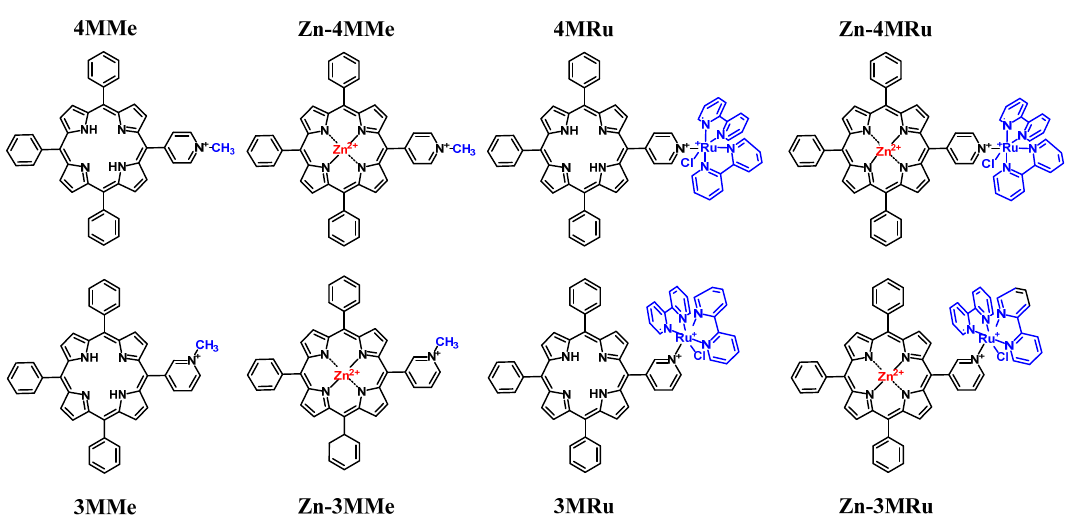
Figure 17. Molecular structures of some hydrophobic porphyrins and metalloporphyrins encapsulated into polymeric nanocapsules by Deda et al.